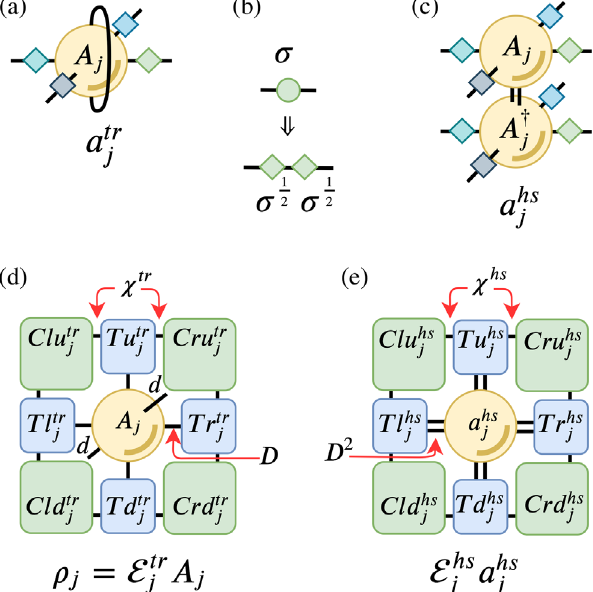
FIG. 3. Environment of the unit cell. Panel (a) shows the tensor a tr ¼ tr d ð A j Þ , which is found by tracing over the physical j dimension, while in panel (c), a HS inner product; in each case, the bond matrices (b) are split in two. (d) Trace effective environment E tr calculate the d × d reduced density matrix ρ effective environment E HS the bond